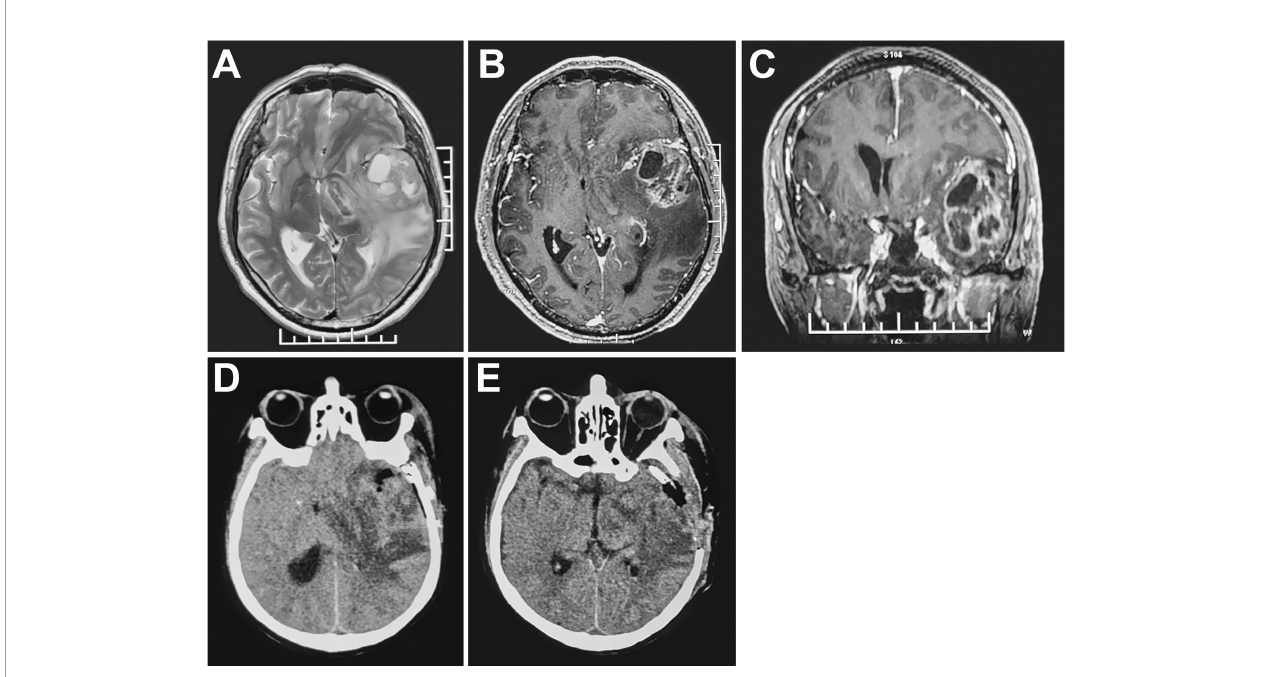
FIGURE 1 | MRI (A-C) high-grade glioma with marked peritumoral edema in the left temporal lobe. CT (D) subtotal tumor resection, obvious midline shift and increased peritumoral edema 48 hours postoperatively. CT (E) Resection of residual tumor and decompressive